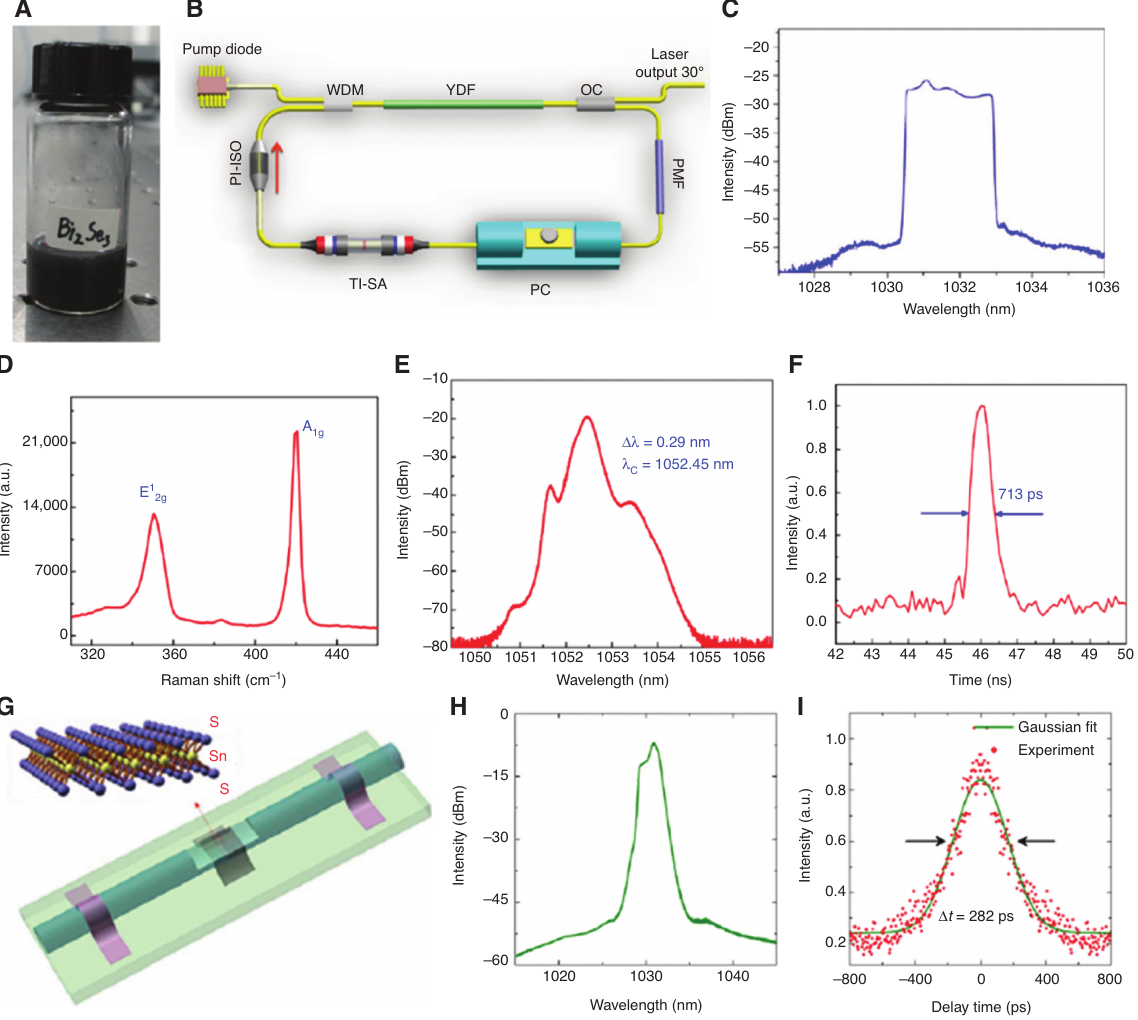
Figure 12: Mode-locked fiber lasers with various SAs at the 1.0- μ m region. (A–C) Bi Te . (A) Solution of Bi Te . (B) Schematic of the fiber laser. (C) Optical spectrum. Reproduced with permission from Ref. [20]. 2 3 2 3 Copyright 2014, Optical Society of America. (D–F) WS . (D) Raman spectrum of WS . (E) Optical spectrum. (F) Pulse profile. Reproduced with 2 2 permission from Ref. [282]. Copyright 2015, Optical Society of America. (G–I) SnS . (G) Schematic diagram of SDF; inset: crystal structure 2 of monolayer SnS . (H) Optical spectrum. (I) Autocorrelation traces. Reproduced with permission from Ref. [279]. Copyright 2017, American 2 Institute of